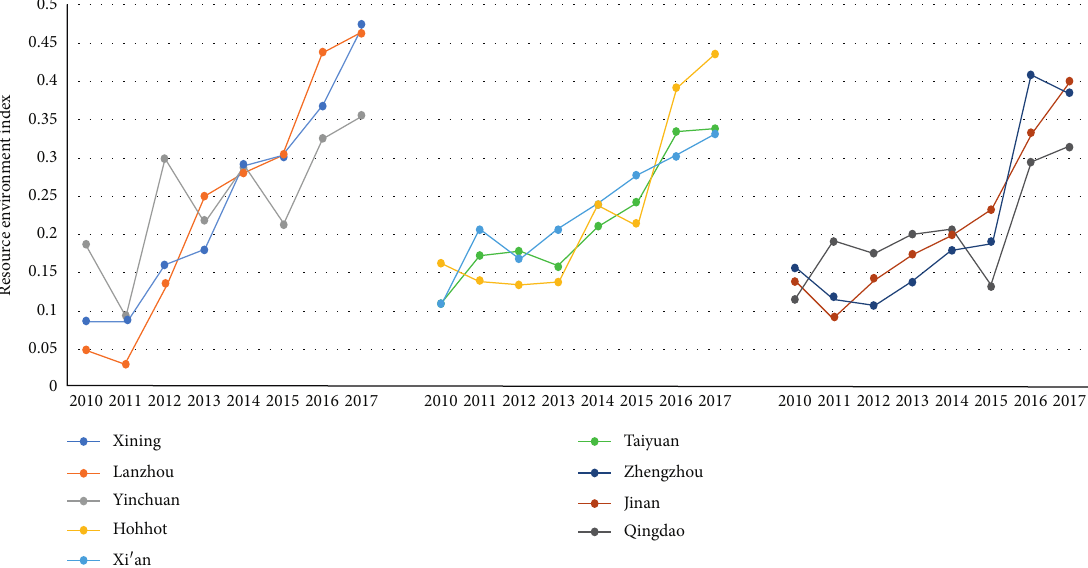
Figure 3: Change trend of the comprehensive level of resources environment.